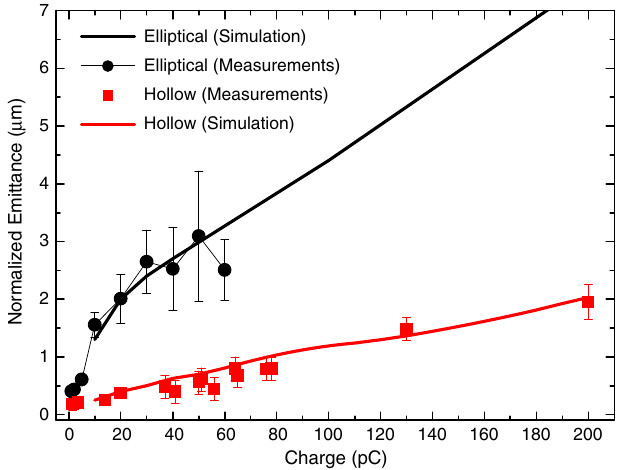
FIG. 6. Projected normalized emittance versus charge for two cathode shapes: elliptical (copper) and hollow (copper insert); (cid:5) mc 2 ¼ 5 : 11 MeV ;